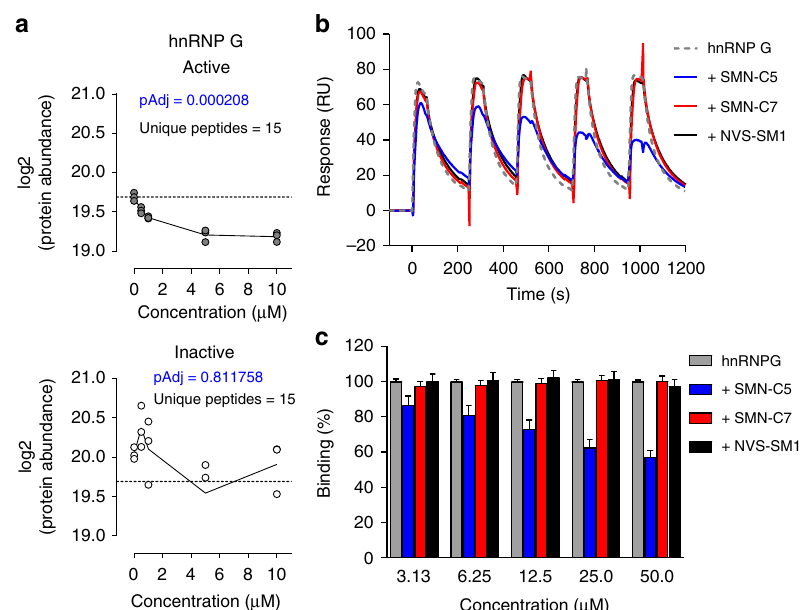
Fig. 6 Displacement of hnRNP G from SMN2 exon 7 ESE2 by small molecule splicing modi fi ers. a Protein abundance (log2) of hnRNP G after af fi nity enrichment with the SMN2 ESE2 RNA sequence as bait, in the presence of increasing concentrations of Active (SMN-C6) or Inactive (SMN-C7) ligand. b SPR-binding curves monitored for hnRNP G RRM over ESE2 surface at a single hnRNP G concentration of 1.5 µ M (green) and competition of hnRNP G-ESE 2 interaction by SMN-C5 (blue), SMN-C7 (red), or NVS-SM1 (black). ESE2 was immobilized on a streptavidin surface (CAP sensor) to a density of ~25 RU. Small molecules were titrated from 3.13 to 50 µ M at constant hnRNP G concentration (1.5 µ M). c Quantitative assessment of normalized SPR signals of competition experiments in b . SPR signals were measured in the middle of the association phase and normalized according to immobilized levels of ESE2. 100% binding corresponds to the binding of hnRNP G to ESE2 at 1.5 μ M. Data in c represent means ± SEM of fi ve independent experiments illustrated in b